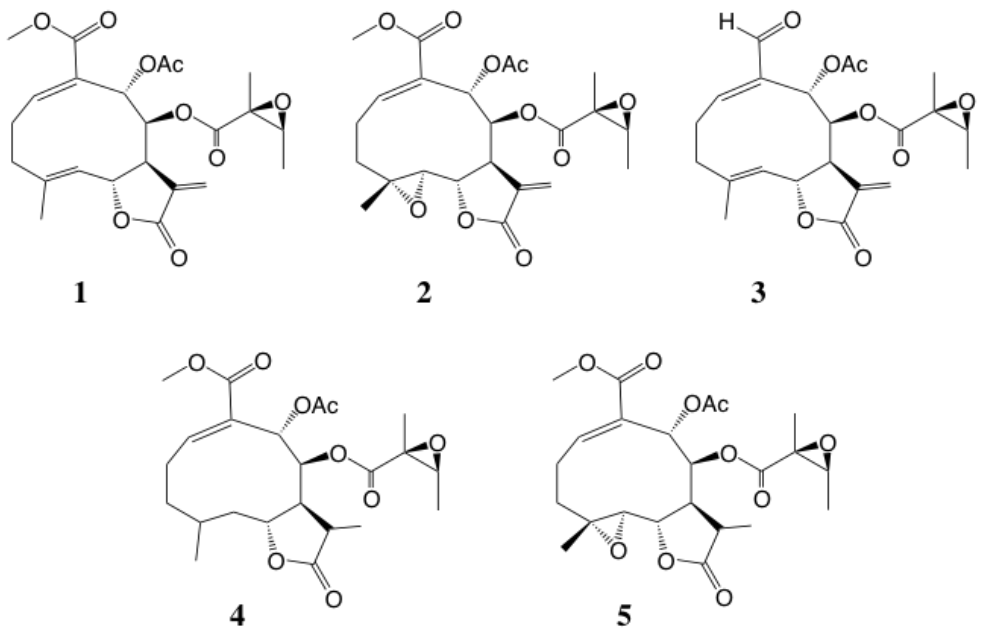
Figure 4. Melampolides and derivatives 1–5 from yacón leaf trichomes. Table 1. Insect antifeedant activity of tested sesquiterpene lactones and azadirachtin A against common cutworm ( S. litura ) third-instar